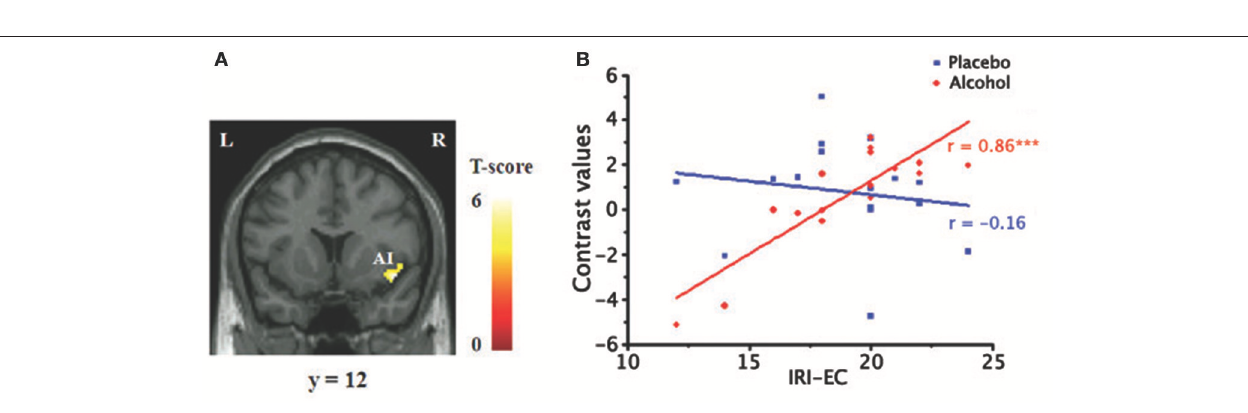
FIGURE 5 | Positive relationship between empathy concern subscale of Interpersonal Reaction Index (IRI-EC) scores and empathic neural responses for pain in the right AI. (A) A significant cluster superimposed onto a coronal section ( p < 0.001, FDR corrected at cluster level), masked by the main effect of empathy (pain > nopain; p < 0.05); (B) A scatter plot of the positive correlation in the peak voxel for display purposes (x/y/z = 44/12/-12, MNI coordinates). *** p <